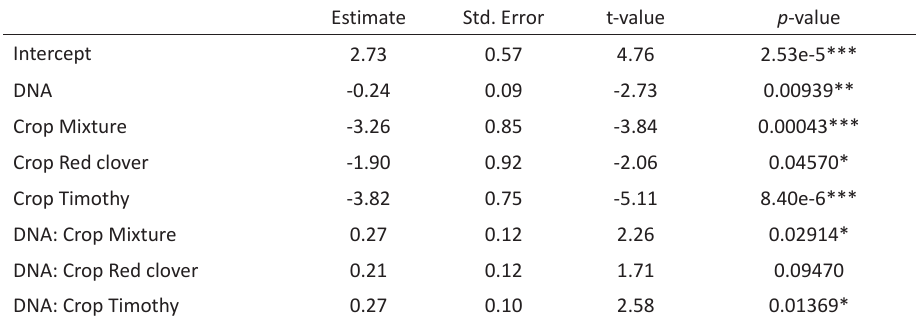
Table 7. Estimated regression parameters, standard errors, t-values and p